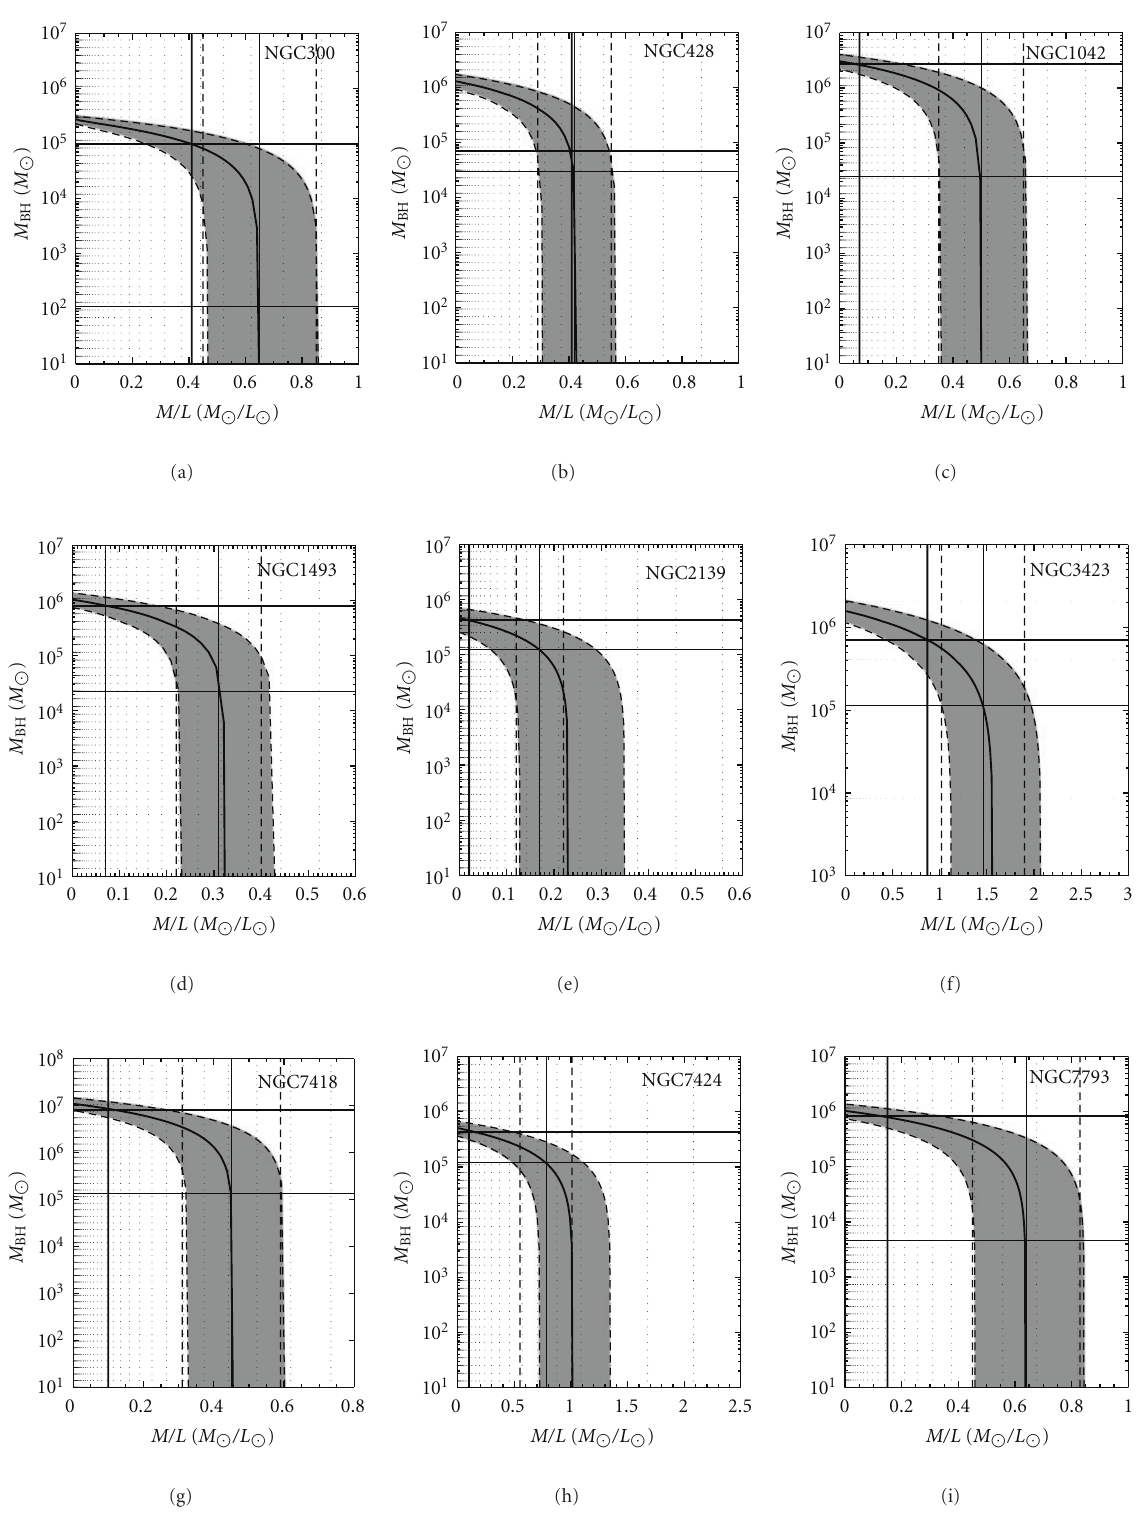
Figure 1: The M / L ratio assumed for the stellar population against the mass of the putative black hole for each of the nine nuclear clusters. Models falling onto the right solid vertical line have the same velocity dispersion as given in Table 1 for each cluster (dashed lines are upper and lower uncertainties). We also draw a vertical, full line (left) for the minimum mass-to-light ratio compatible with the observed spectrum of the stellar population in the cluster. The horizontal solid lines indicate the black hole masses referring to the two di ff erent M / L values (upper line) and for the best-fit stellar quoted previously. For the minimum M / L we find a firm upper limit to the black hole mass M max BH (lower populations M / L we get M best BH